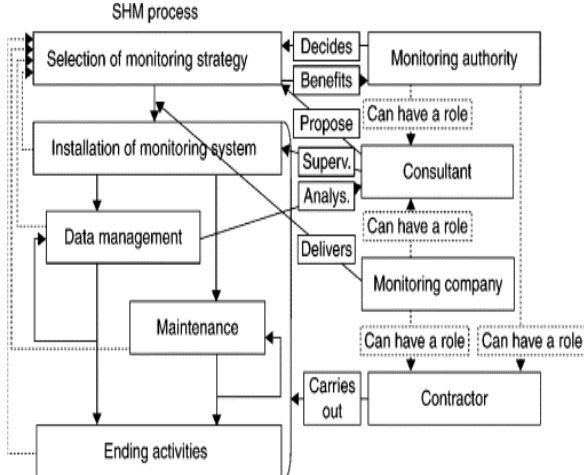
Figure 1. Flow chart for structural health monitoring